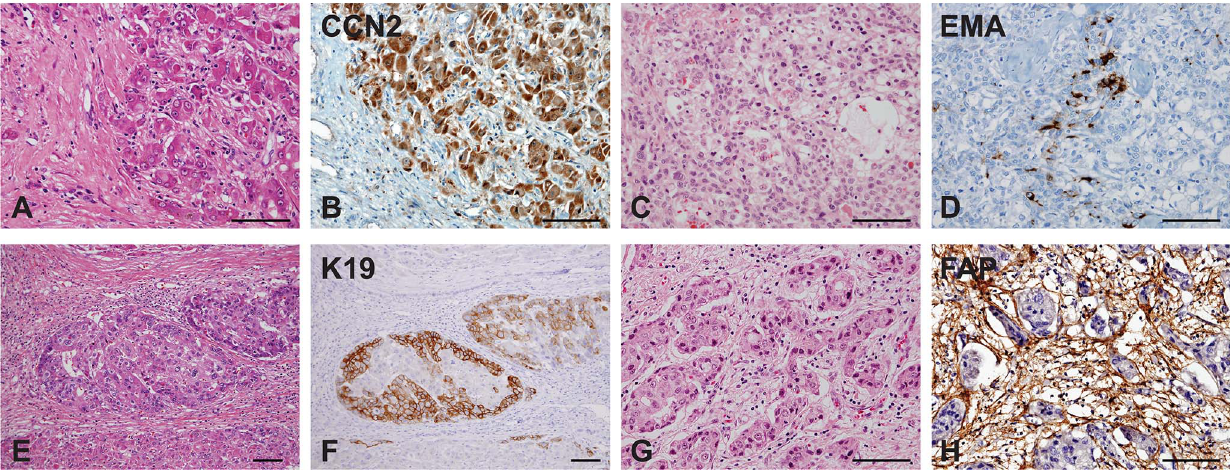
Figure 1. Connective tissue growth factor (CCN2), epithelial membrane antigen (EMA), fibroblast activation protein (FAP), and keratin 19 (K19) expression in hepatocellular carcinomas (HCCs) of cohort 1. A) Small nests of tumor cells are surrounded by fibrous stroma. B) Immunohistochemistry for CCN2 exhibits diffuse cytoplasmic expression in tumor epithelial cells of HCC. C–D) Immunohistochemistry for EMA reveals patchy or focal expression pattern in tumor epithelial cells of HCC. E–F) K19 is focally positive in the periphery of tumor nests. (G–H) FAP is expressed in the cytoplasm of cancer-associated fibroblasts of tumor stroma. (Scale bars represent 100 m m.)